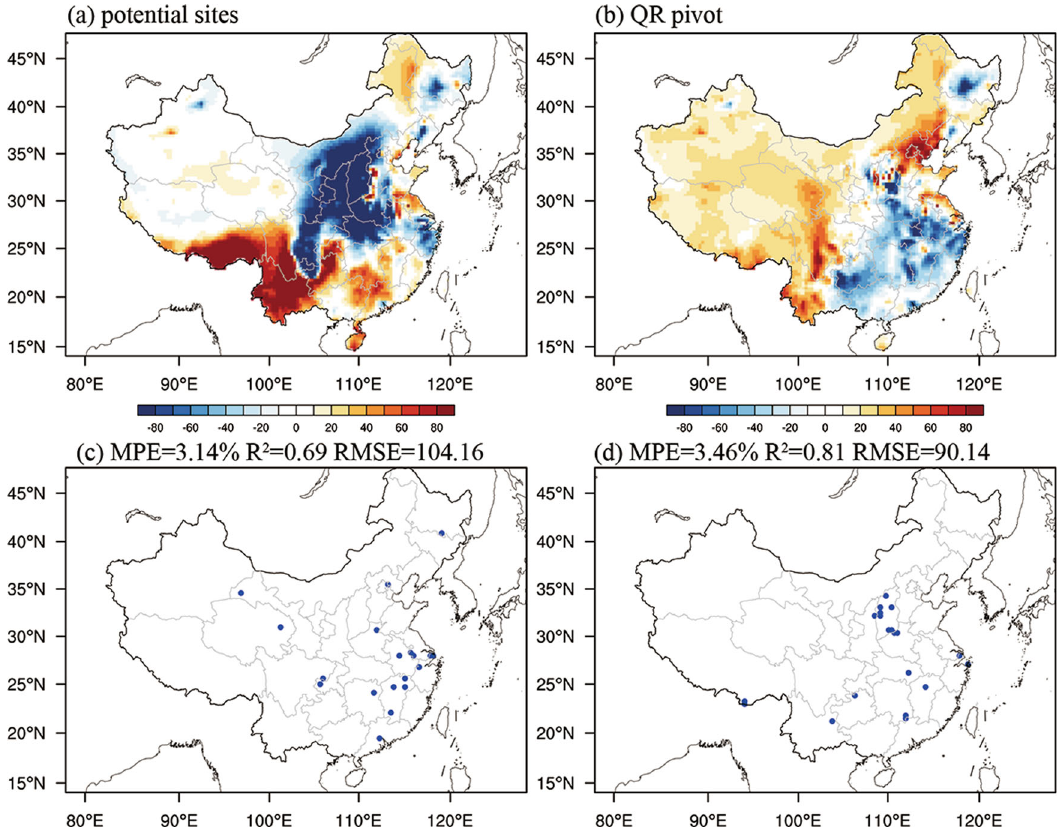
Fig. 5 Difference in reconstruction ability using potential sites and QR pivot algorithm. Differences between simulated and reconstructed surface CH